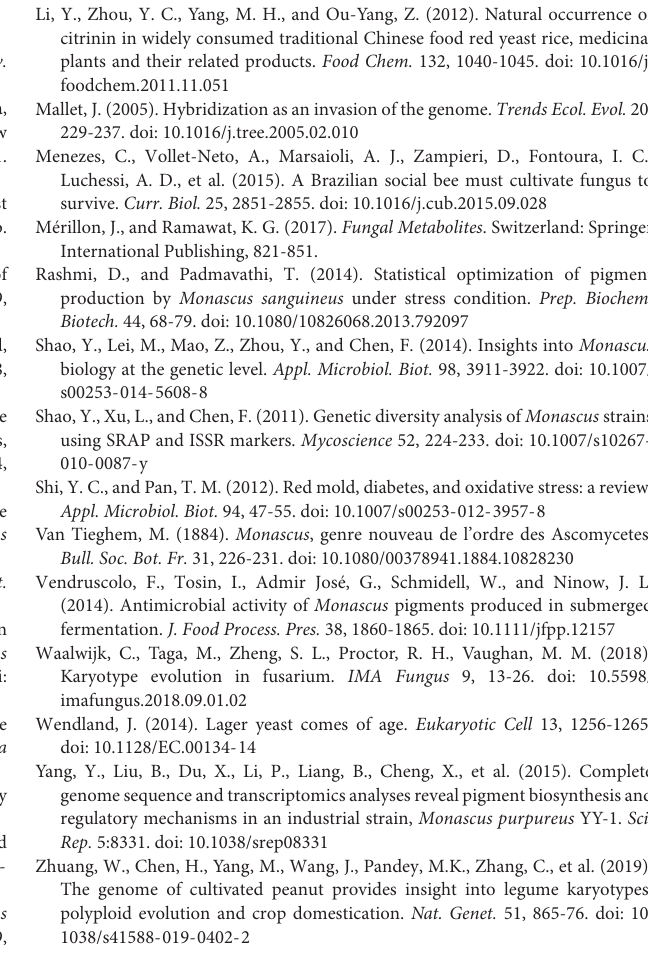
Supplementary Figure 2 | Two haplotypes of the BenA gene of four M. sanguineus strains (only inconsistent sequences are retained after alignment). Supplementary Figure 3 | Cultural characters of 15 Monascus strains cultured on MEA, PDA, and CYA media at 30 ◦ C for 7 days. Supplementary Figure 4 | Mean growth rates (mm/d) of 15 Monascus strains cultured on PDA, MEA and CYA media at 30 ◦ C for 7 days. Supplementary Table 1 | Genes sequenced and primers for PCR. Supplementary Table 2 | GenBank accession numbers of sequences used in the molecular